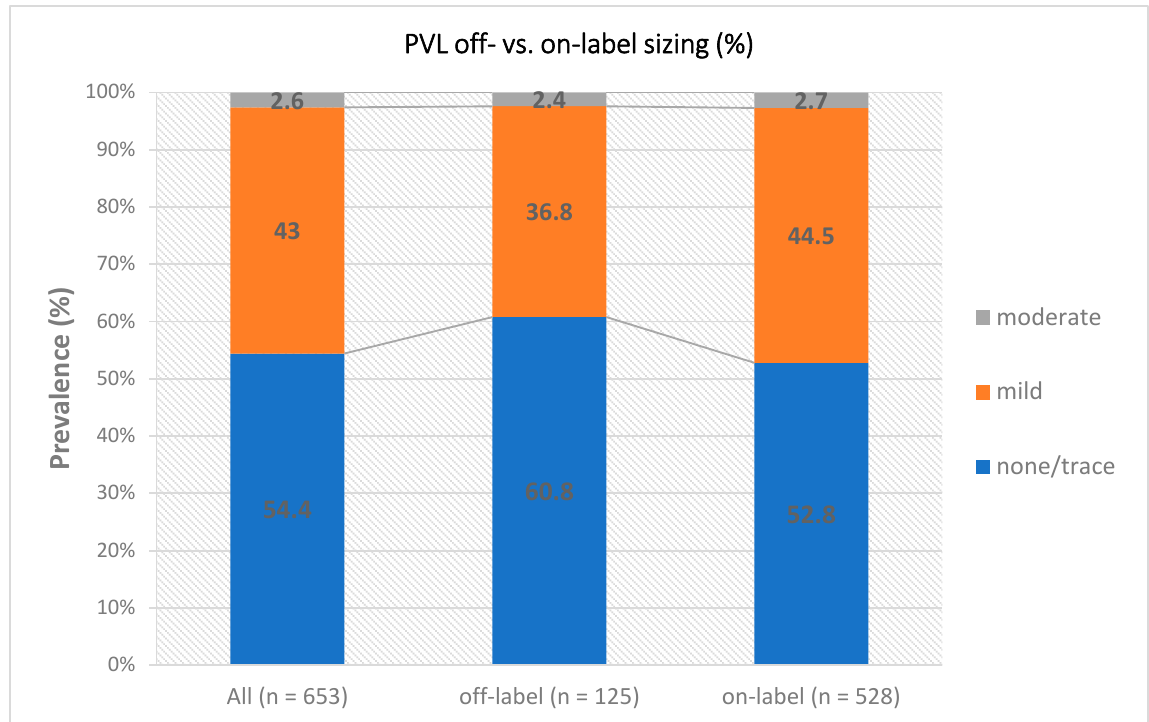
Figure 1. PVL on- vs. off-label sizing. Abbreviation: PVL = paravalvular leak.